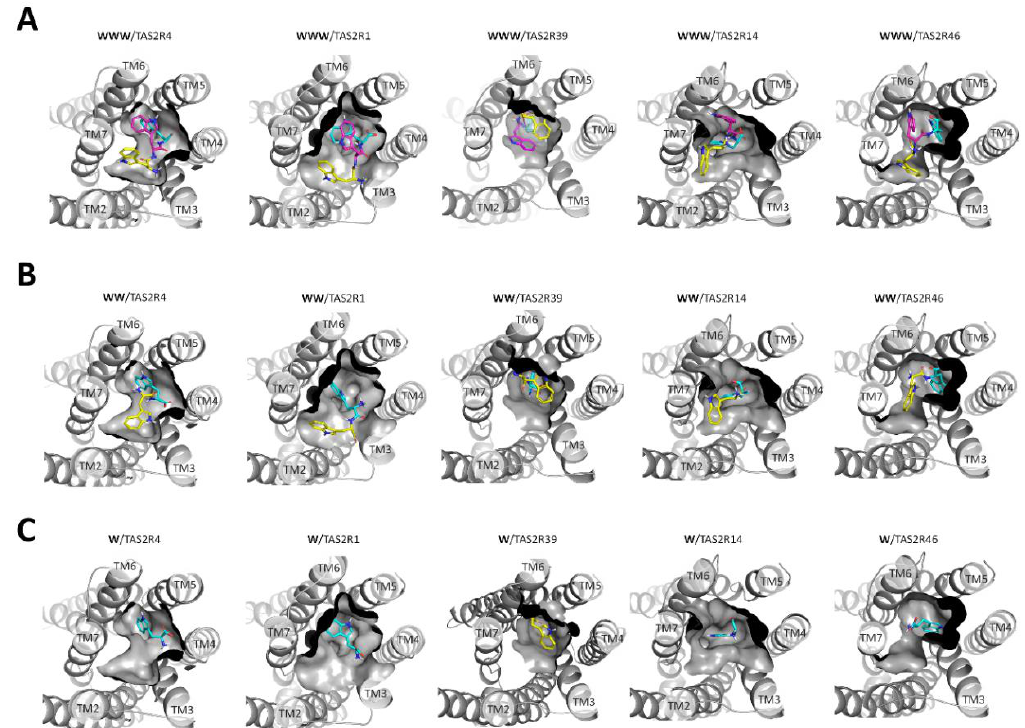
Figure 1. Predicted binding modes of tri-tryptophan ( A ), di-tryptophan ( B ), and tryptophan ( C ) into the binding sites of TAS2R4, -R1, -R39, -R14, and -R46. The receptors are shown in the same orientation in all representations. Tryptophan residues are colored in cyan when accommodated at the bottom of the orthosteric binding site, in magenta when close to the extracellular space, and in yellow when in between. Receptor sub-pockets are shown in Supplementary Material Figure S2.